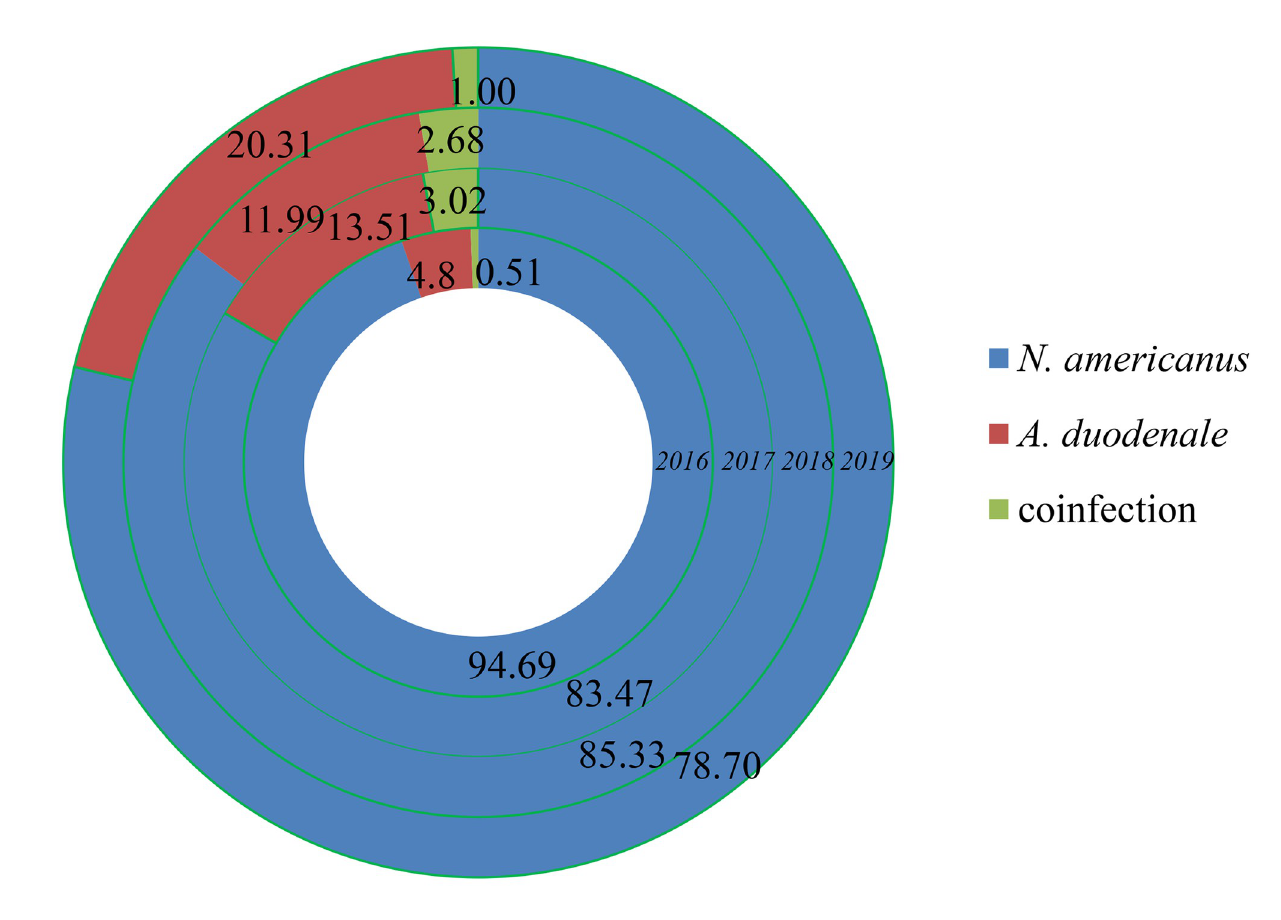
Fig 9. Constituent ratio (%) of hookworm species in China from 2016 to